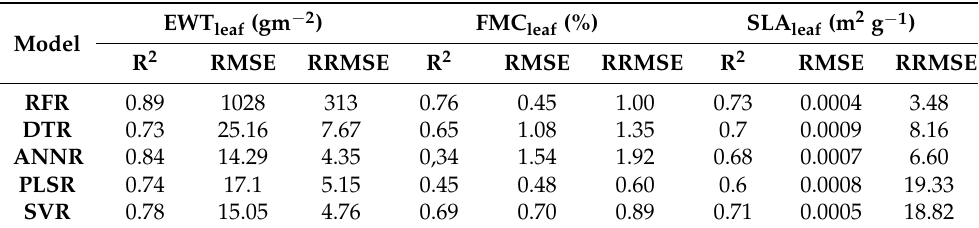
Table 5. Prediction accuracies of EWT leaf , FMC leaf , and SLA leaf were derived using optimal models based on the RFR, DTR, ANNR, PLSR, and SVR regression